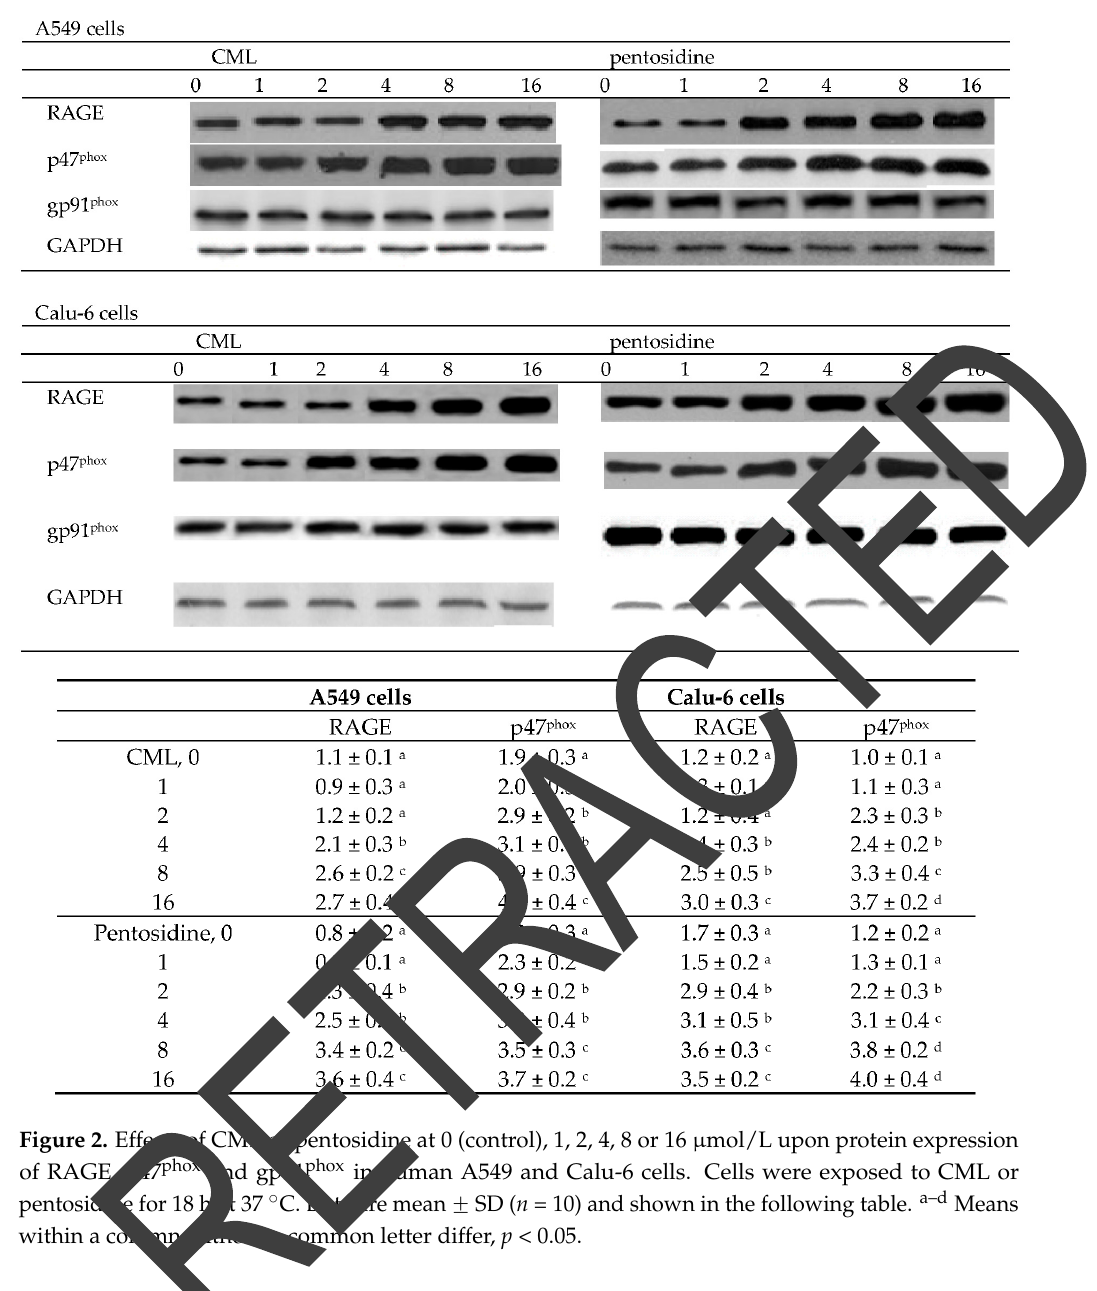
Figure 2. Effects of CML or pentosidine at 0 (control), 1, 2, 4, 8 or 16 μ mol/L upon protein expression of RAGE, p47 phox and gp91 phox in human A549 and Calu-6 cells. Cells were exposed to CML or pentosidine for 18 h at 37 °C. Data are mean ± SD ( n = 10) and shown in the following table. a–d Means within a column without a common letter differ, p < 0.05.